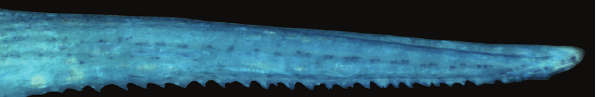
Fig. 3. Right pectoral spine (11.4 mm long) of Corydoras eversi , paratype, NUP 17310, 45.3 mm SL, showing the serrations on posterior margin.